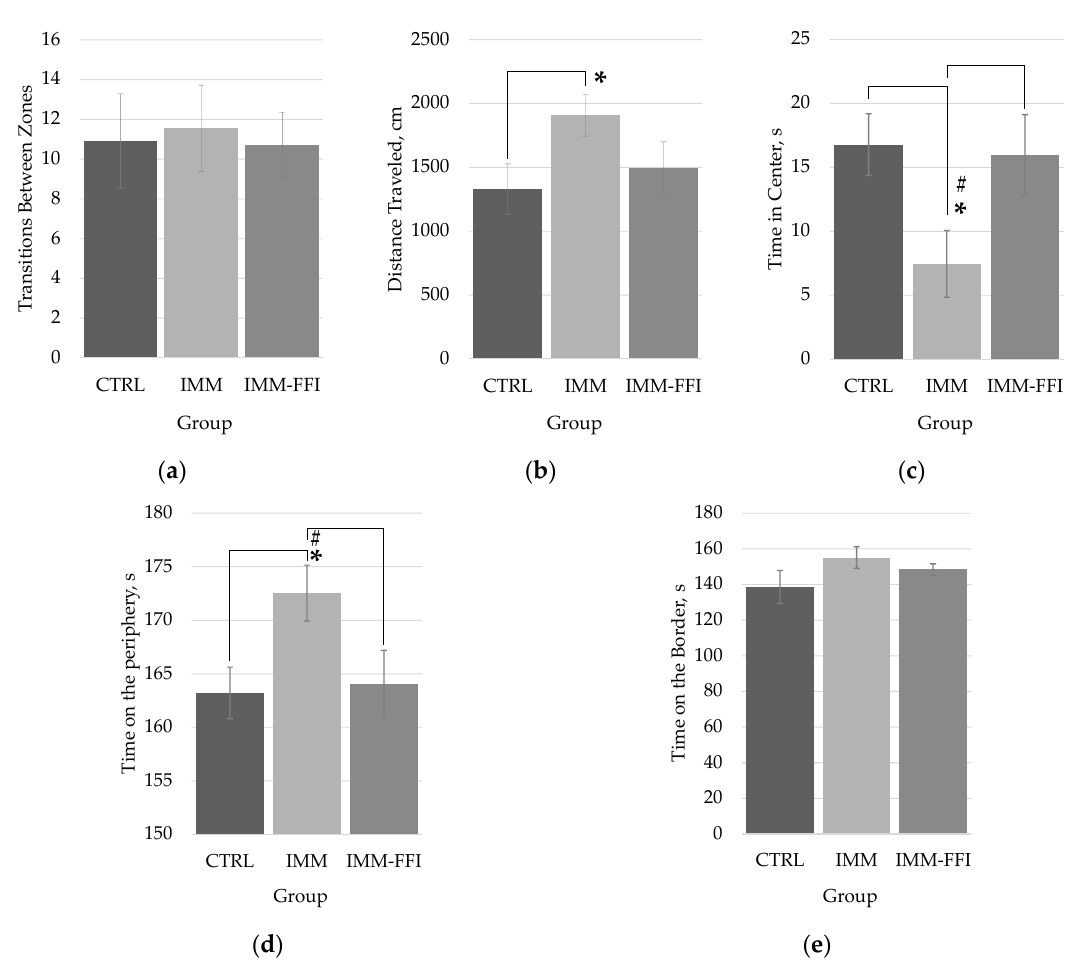
Figure 3. OF testing results on 22nd day of the experiment: ( a ) a number of transitions between zones; ( b ) distance traveled, cm; ( c ) time spent in the central zone, s; ( d ) time spent on the periphery, s; ( e ) time spent on the border, s. *—differences are significant compared with the CTRL group, p < 0.05. # —differences are significant compared with the IMM-FFI group, p < 0.05. Assessment of short-term and long-term memory, as well as the cognitive functions of rats, were evaluated in the CPAR test (Table 2). During the first testing, the develop- ment of conditioned reflex of passive avoidance, animals of all groups entered the dark compartment of the camera (100% reflex production). On the 2nd day of testing, there were no significant differences in short-term memory between the groups. On the 14th day of long-term memory testing, an increase in the latency period of entry of animals of the IMM-FFI group into the dark compartment of the camera was found, along with a decrease in the number of animals that failed the test, compared with the CTRL control group. The obtained result indicates an improvement in the long-term memory of animals receiving FFIs against the background of immobilization